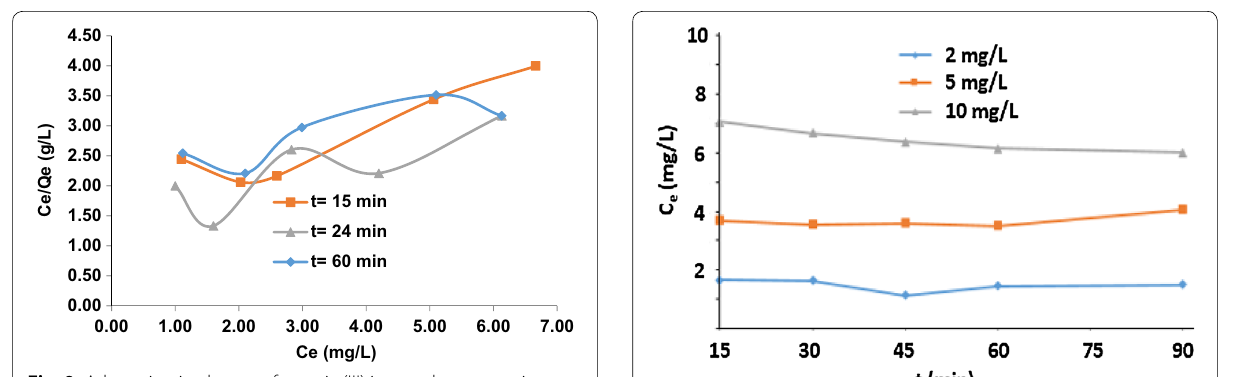
Fig. 9 Adsorption isotherms of arsenic (III) ion on the composite HAp/GA at t 15 min, t 24 min and t 60 min, linearized accord- = = = ing to Langmuir